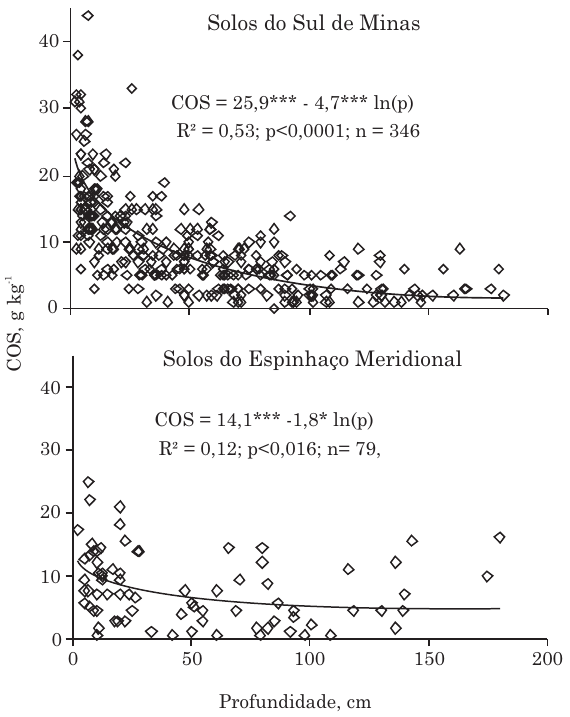
Figura 2. Perfis de carbono orgânico do solo (COS) para as regiões Sul e Serra do Espinhaço Meridional, MG. O nível de significância para os parâmetros intercepto e fator logarítmico é representado por *,** e ***, respectivamente, para p<0,05, p<0,01 e